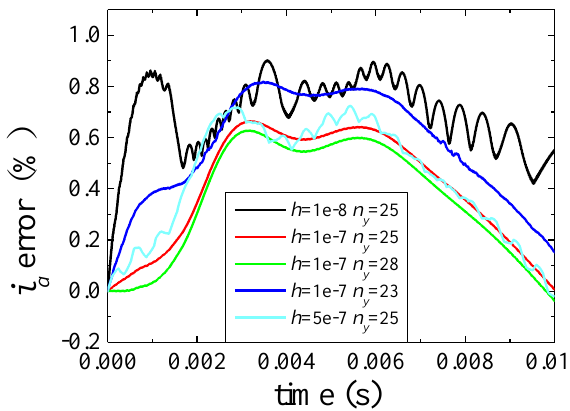
Figure 10. Error Comparison Diagram.